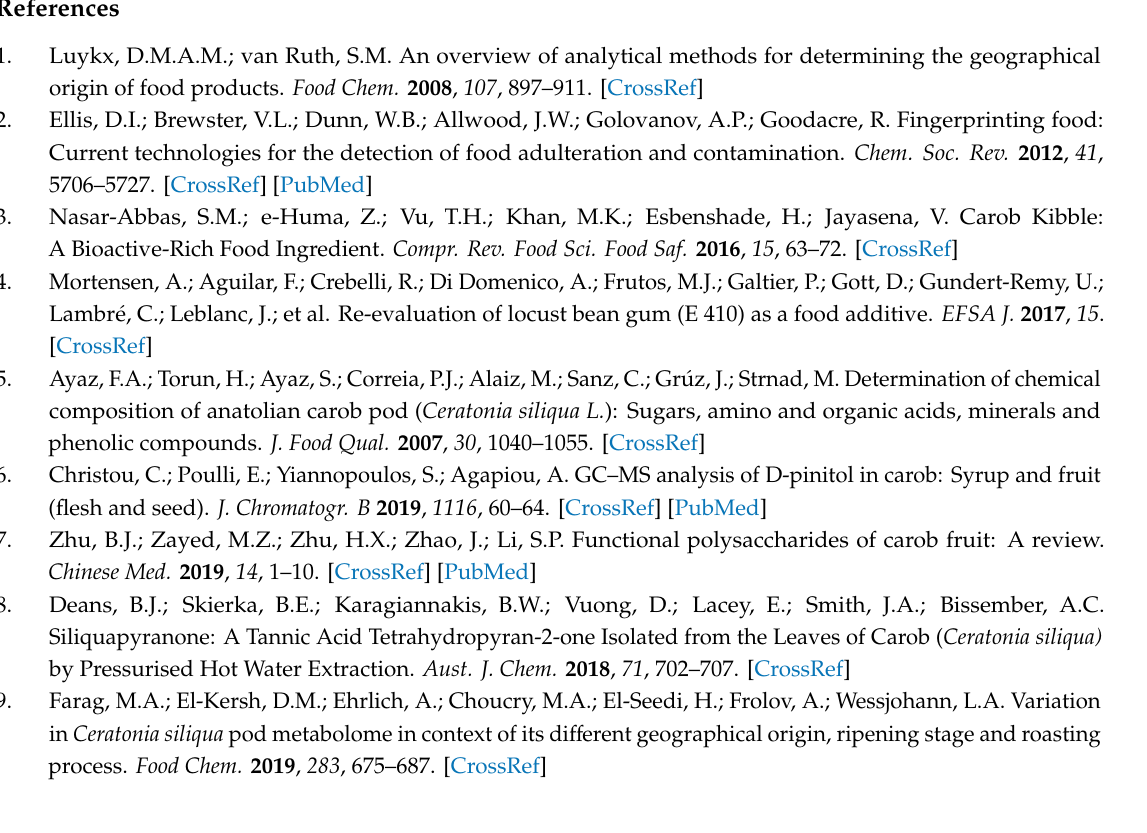
Figure S1: PCA scatter plot of 54 carob samples, according to their variety (C: Cyprus, G: Greece, I: Italy, S: Spain, T: Turkey). Figure S2: Contribution plots of the 12 varieties based on the PCA model (Figure S1). Table S1: Results obtained from the analyses of carobs (flesh and